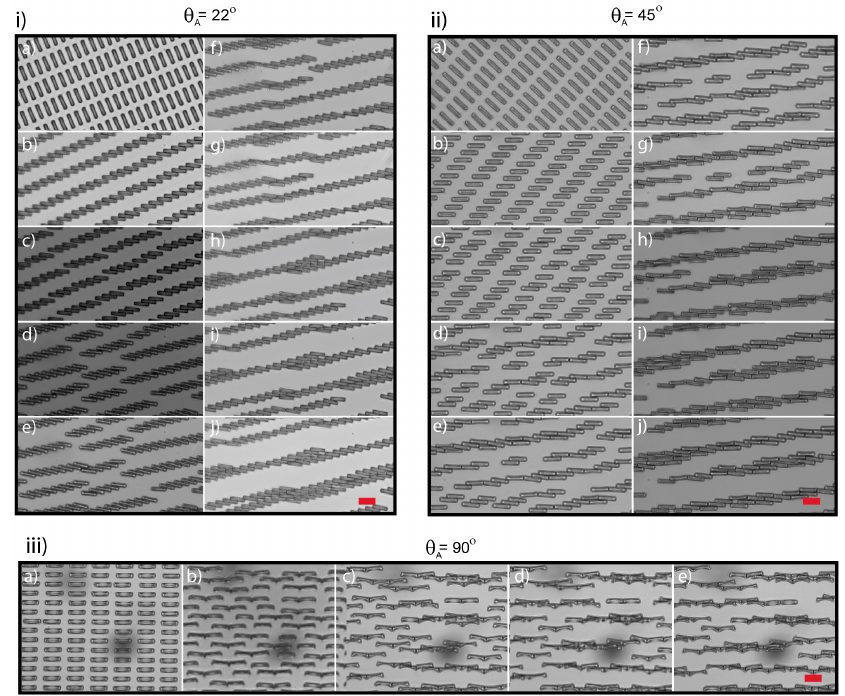
Figure 3. Long term assemblies at θ A = 22, 45 and 90° ( i – iii ), respectively. The time interval between panels (a–j) is 15 and 2.5 s ( i ) and ( iii ), respectively. For ( ii ), the time interval between panels (a–e)